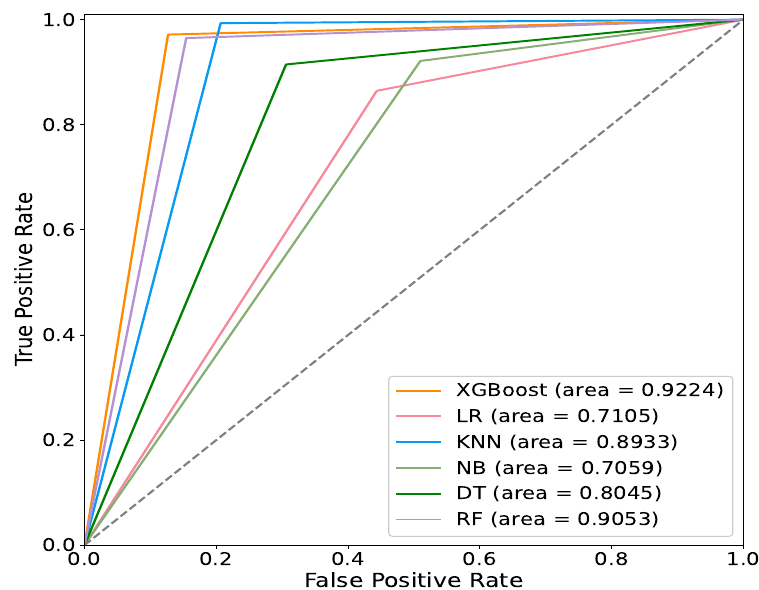
Figure 6. The ROC curve of baseline algorithms and Xgboost.